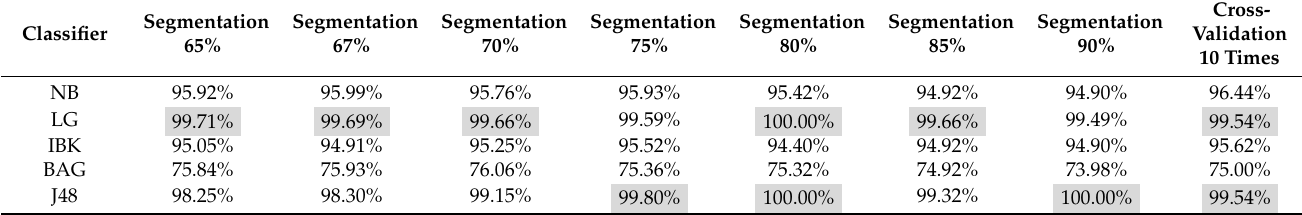
Table 9 lists classifier analysis with no-feature selection for the ratio 3:1, and Table 10 lists classifier analysis with feature selection. From Table 9, LG and J48 have better accuracy performance, and those of J48, BAG, and IBK are superior to the others in Table 10. Table 9. The classifier accuracy of no-feature selection for 1473 normal and 491 bankrupt companies (3:1).